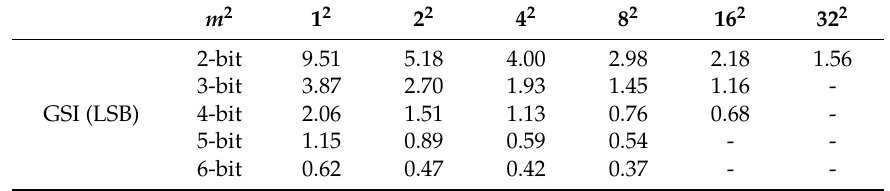
Table 2. The GSI values for different bit depths and spatial oversampling factors with U thn =